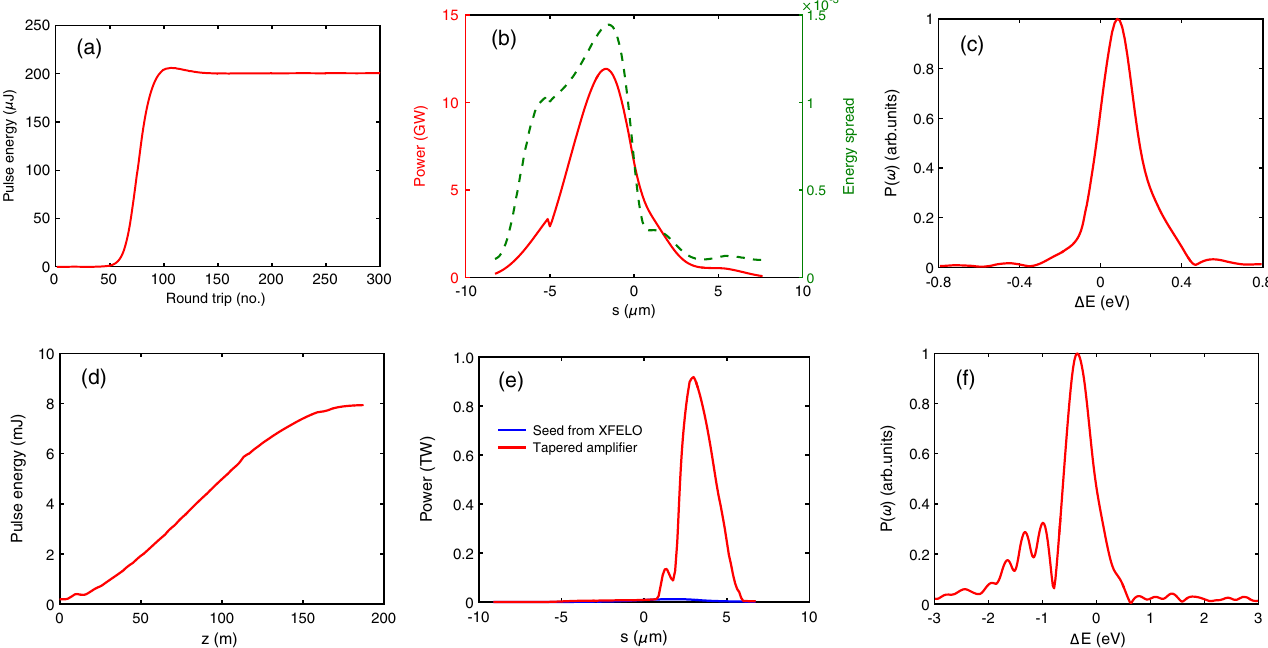
FIG. 5. The performance of 3 kA peak current flat-top electron beam for XFELO with 18% crystal mirror output coupling. The top row shows (a) output pulse energy gain, (b) power profile (red solid line) and beam energy spread (green dashed line), (c) spectrum for XFELO, while the bottom row plots the FEL amplifier energy gain (d), seed (blue line) and output power profile (red line) (e), and spectrum at the end of undulators